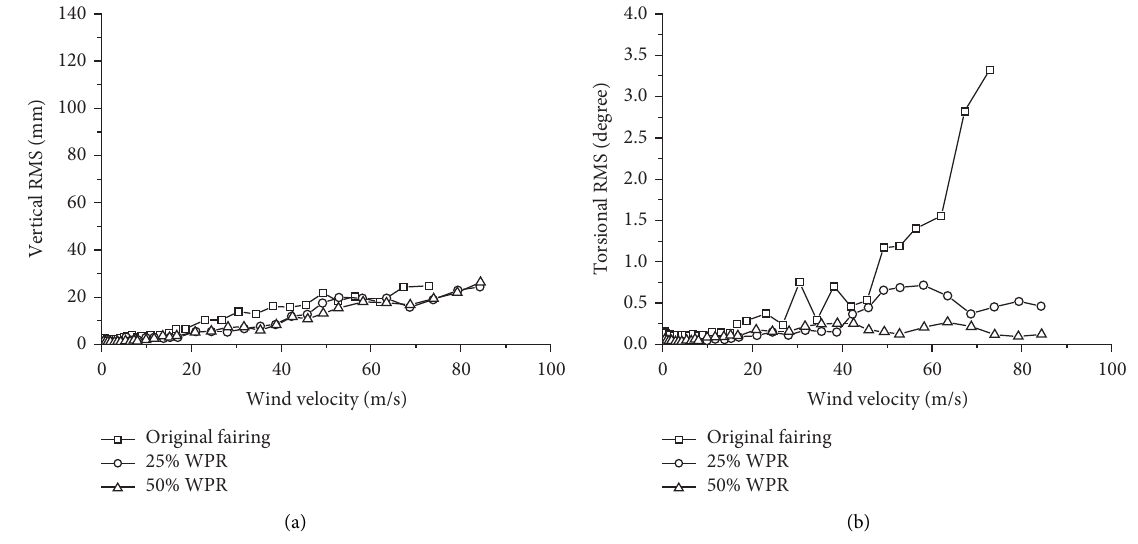
Figure 18: RMS versus wind velocity in turbulent flow (attack angle 3 ° ): (a) vertical RMS; (b) torsional